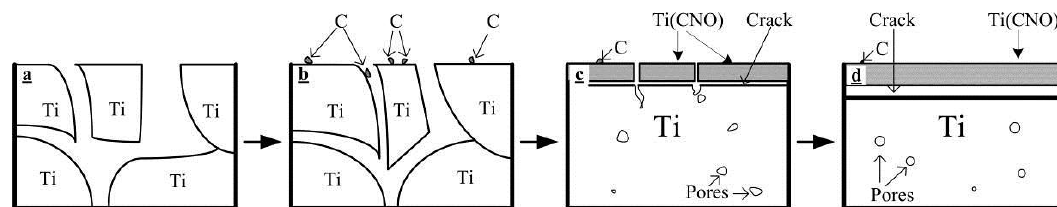
Figure 10. Schematic of the formation process of the contaminated scale. ( a ) Starting powder compact; ( b ) contaminants such as C are deposited on the Ti powder particles; ( c ) Ti reacts with the contaminants forming Ti(CNO). Cracking occurs as a result of different coefficients of thermal expansion; ( d ) larger cracks and more pores are formed at a higher temperature.